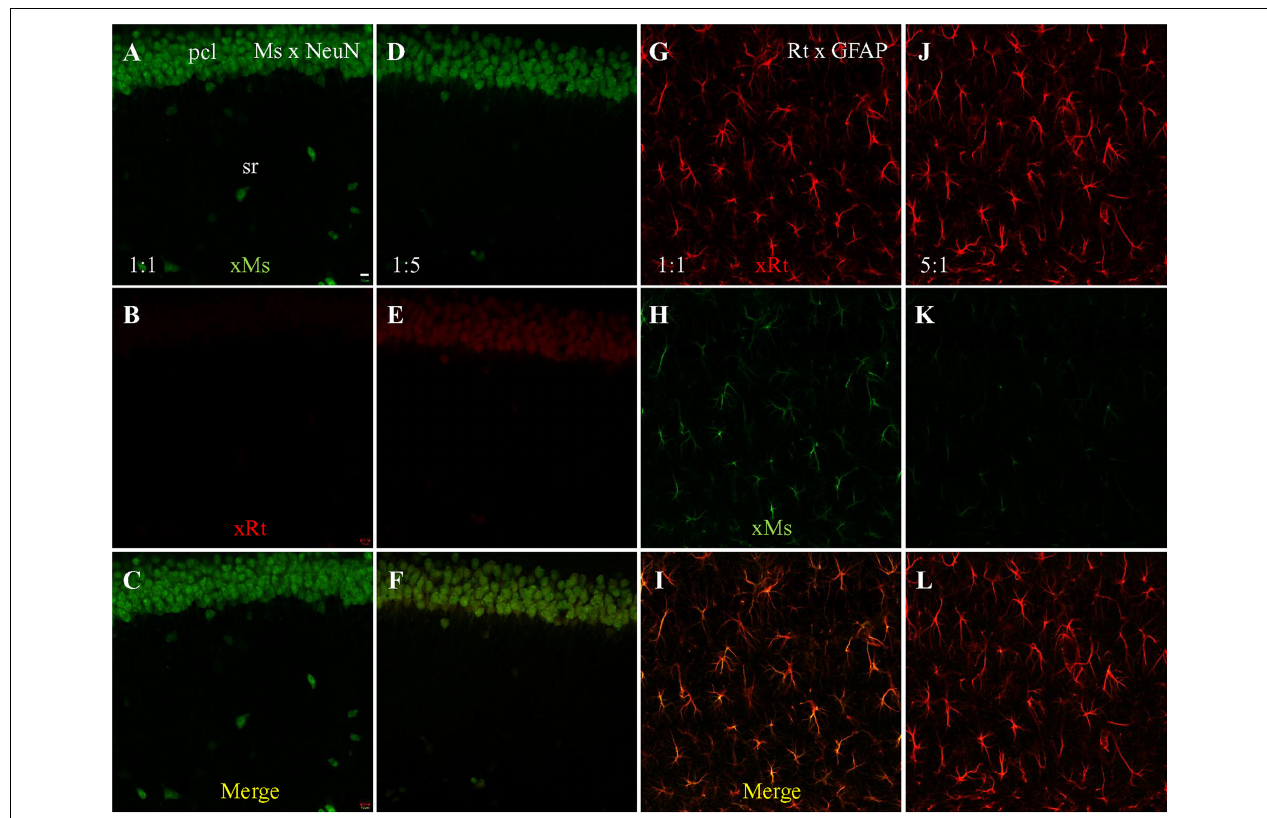
FIGURE 3 | Single staining with mouse anti-NeuN or rat anti-GFAP primary, visualized with dual secondaries at different dilution. Single confocal photomicrographs acquired from hippocampal area CA1. (A–C) NeuN staining visualized with goat anti-mouse (green) and goat anti-rat (red) secondaries, both at dilution of 1:200. Strong same species neuronal staining is present in A as expected, and no cross-species staining is visible in (B) , suggesting that the same-species anti-mouse secondary out-competed the cross-species anti-rat secondary. (D–F) NeuN staining visualized with 1:500 of anti-mouse and 1:100 of anti-rat secondaries. Even at a lower concentration (1:500) neuronal same-species anti-mouse staining is still clearly visible in (D) . In panel (E) , even though no rat primary antibody was used, anti-rat secondary still shows faint staining, but in a cross-species neuronal pattern. (G–I) GFAP staining visualized with both secondaries at 1:200. (J–L) GFAP staining visualized with 1:100 of anti-rat and 1:500 of anti-mouse secondaries. Comparative dilution of same-species and cross species secondaries was shown in each immunostaining setting. xMs/xRt, (goat) anti-mouse, or anti-rat secondary. Scale bar: 10 µ m for all